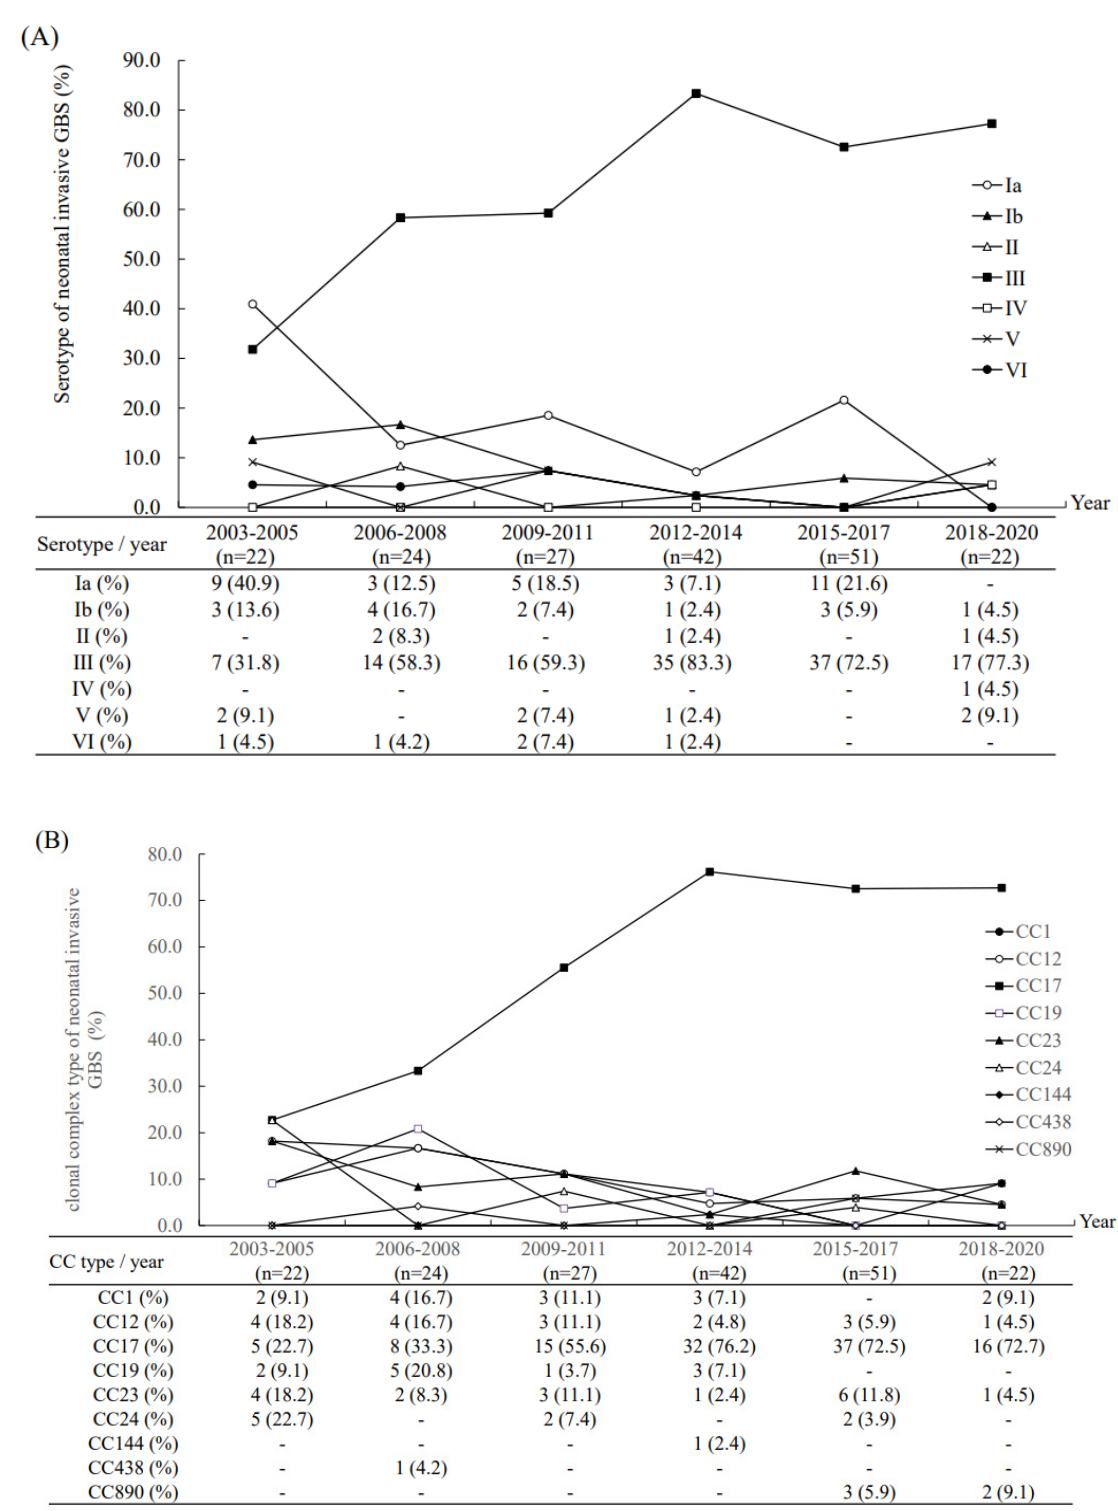
Figure 2. The percentage of all group B streptococcal (GBS) invasive diseases in neonates hospitalized in the neonatal intensive care unit of Chang Gung Memorial Hospital during an 18-year study period: ( A ) The percentage of six serotypes in six time periods; ( B ) the percentage of clonal complexes in six time periods.